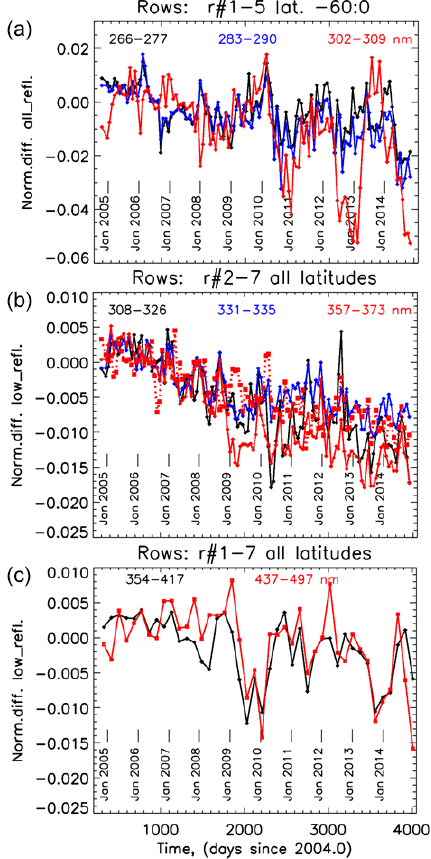
Figure 29. (a) The de-trended, normalized time-, wavelength-, latitude- and row-binned UV1 radiances. (b) The same for UV2 for the low-reflectivity (<10%) subsample (full red line) and the high-reflectivity (>80%) data (dotted red line) for the 357–373nm range. (c) The low-reflectivity, binned radiance trends for VIS. Note the change of the y -axis plotting scales for different OMI channels.